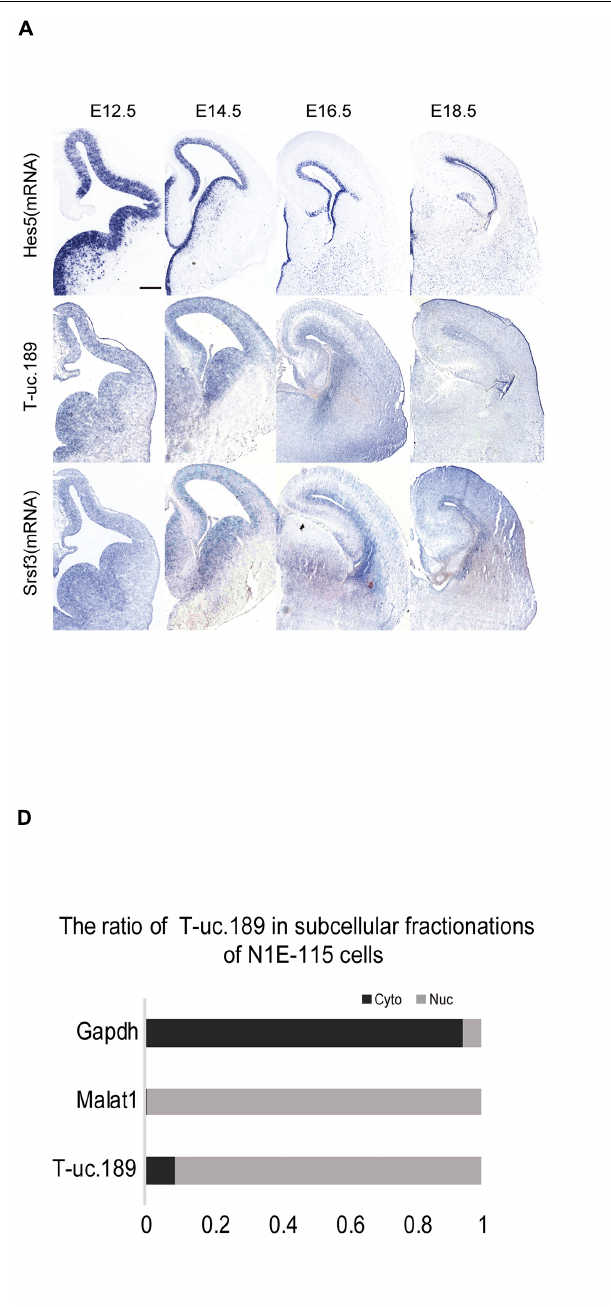
Frontiers in Neuroscience |